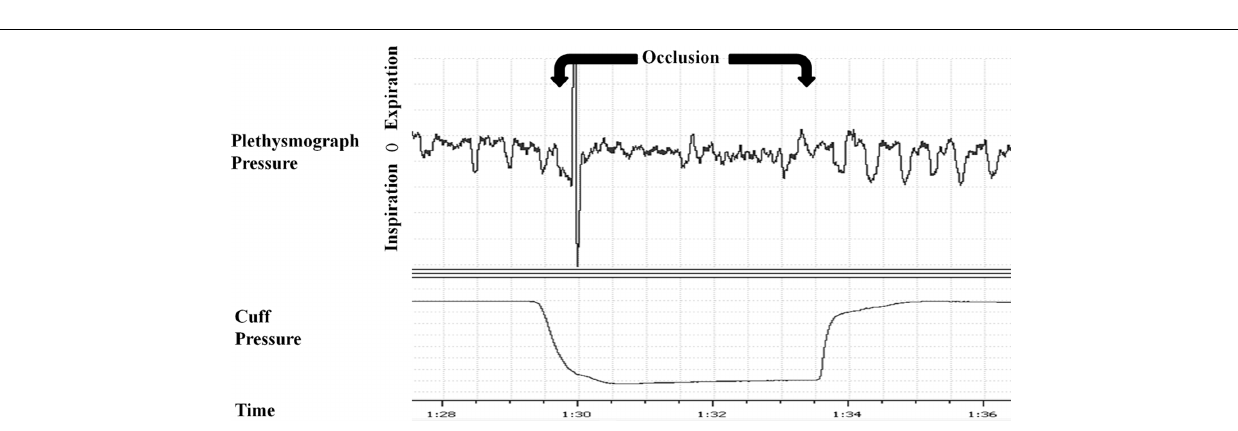
FIGURE 2 | Representative plethysmograph pressure traces for one occlusion trial on day 10. The period of occlusion is indicated on the plethysmograph pressure.The large deflection of the signal at the beginning of occlusion is ascribed to a movement artifact due to the rat’s withdrawal reflex at the onset of